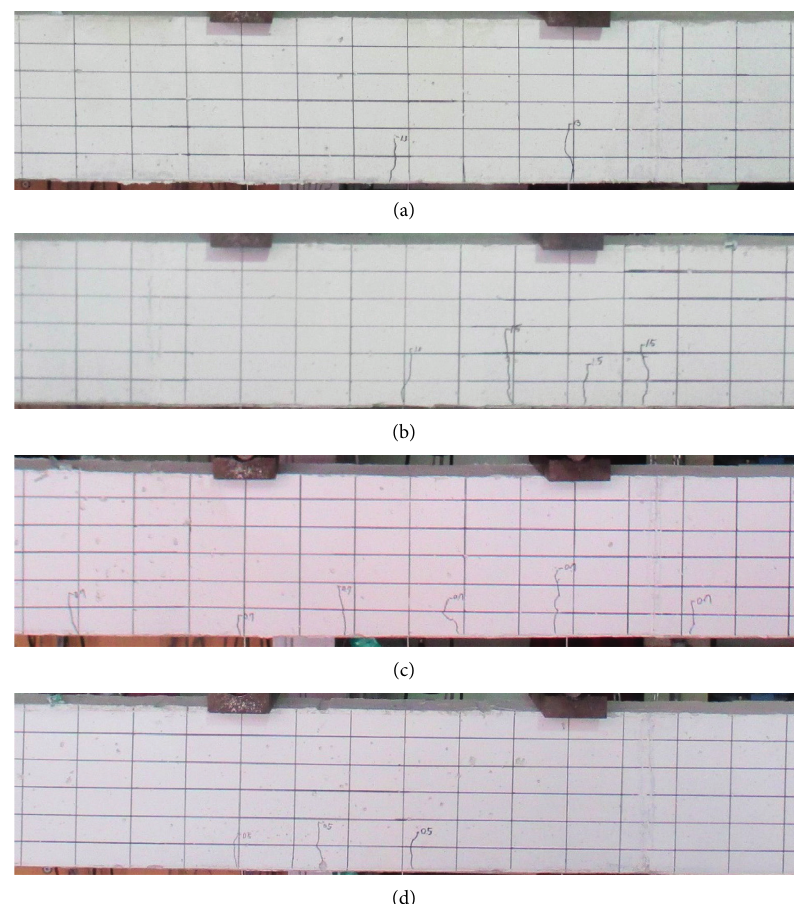
cr ) (S2 series beams). (a) Beam R000-S2. (b) Beam R030-S2. (c) Beam